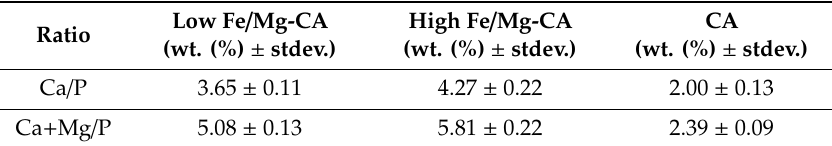
Table 3. Estimation of Ca / P and Ca + Mg / P ratios (wt.(%) ± standard deviation) of low and high Fe / Mg-CA NPs.